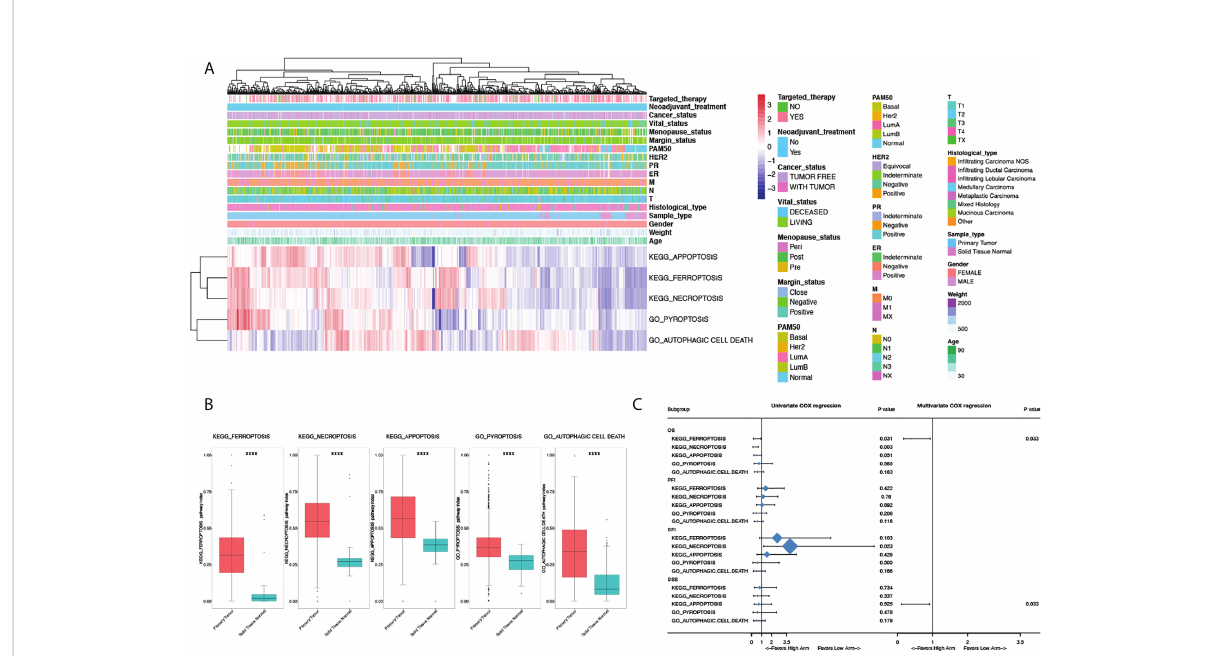
FIGURE 1 Clinical characteristics and prognostic signi fi cance of programmed cell death pathway alterations in breast cancer. (A) Heatmap illustrating pathway deregulation score (PDS) of PCD pathways in breast cancer generated with clinical annotations from TCGA BRCA data; colors were row-scaled and zero-centered. (B) Comparisons of PDS between sample types. (C) Univariate and multivariate Cox regression of PCD pathways in breast cancer regarding overall survival (OS), progression-free interval (PFI), disease-free interval (DFI), and disease-speci fi c survival (DSS). Hazard ratio (HR) and 95% con fi dence interval (95%CI) were shown in the forest plot. For multivariate Cox regression, all pathway scores were enrolled and forward stepwise regression was done with the ER/PR/HER2 status, age, and T/N/M stage treated as confounders. P -value < 0.05 was considered signi fi cant. A two-sided P -value < 0.05 was considered signi fi cant. ****P <